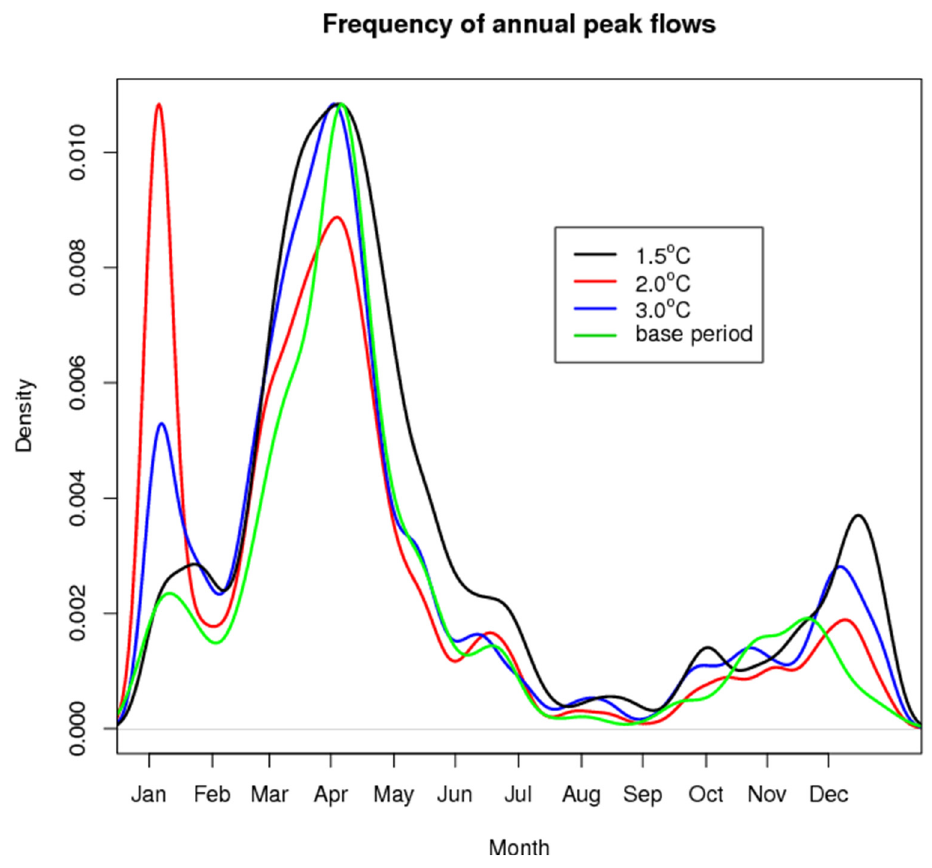
Figure 4. Probability distribution of the timing and frequency of annual peak flow events (above 95th percentile in the flow distribution) under different levels of temperature increase relative to the base period